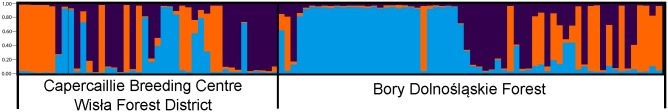
Clustering results of combined CBC-WFD and BDF population revealed with STRUCTURE.Three distinct genetic clusters were present: one consisted of individuals from Belarussian lineage (orange) and two of Western Carpathian lineage (blue and violet). Each line represents one individual and the amount of the colour indicates estimated membership of the individual in a distinct genetic cluster.